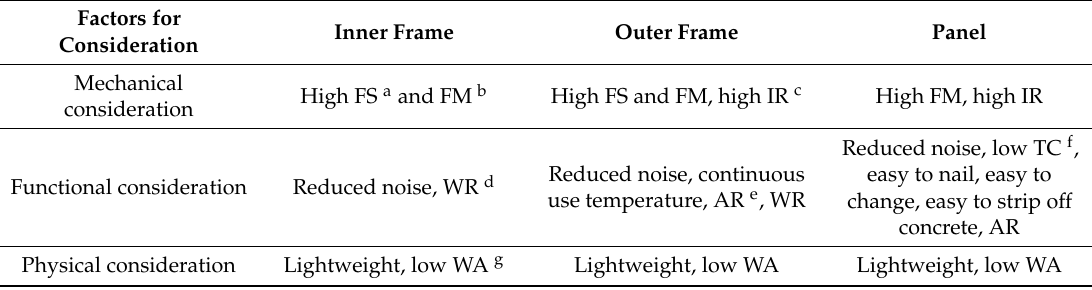
Figure 3. Basic concrete system form module used in South Korea. An outer frame ( a ), a panel ( b ), an inner frame ( c ). Table 4. Technical requirements for form materials.